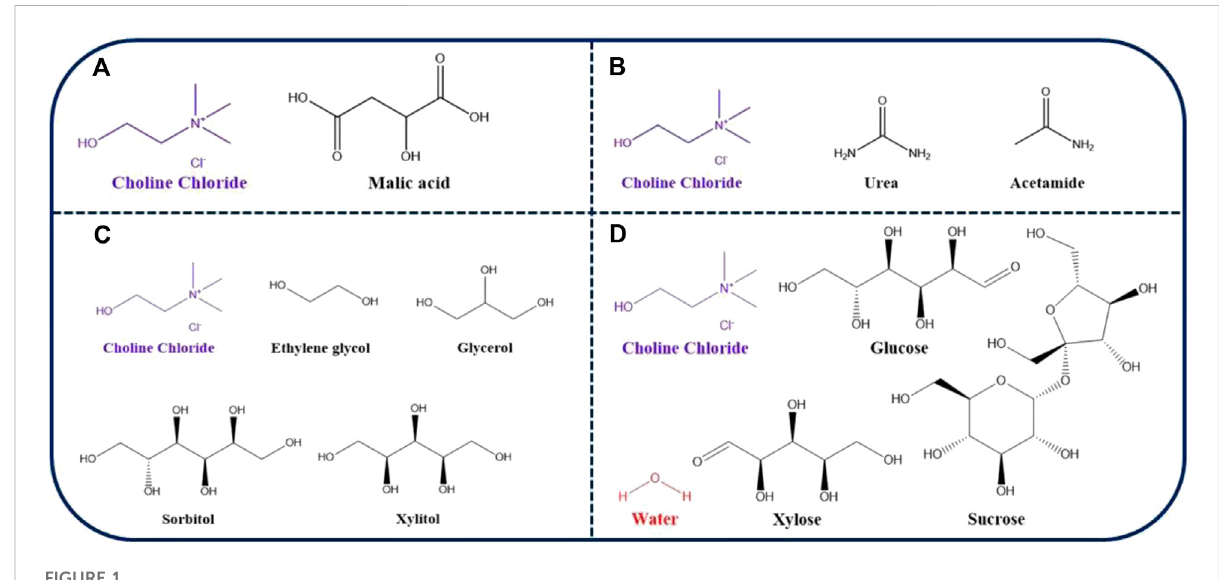
FIGURE 1 ChemicalstructuresofthemostusedHBA(ChCl)andHBDsinordertoformDESscommonlyappliedtoproteinextractionandpuri fi cationwith